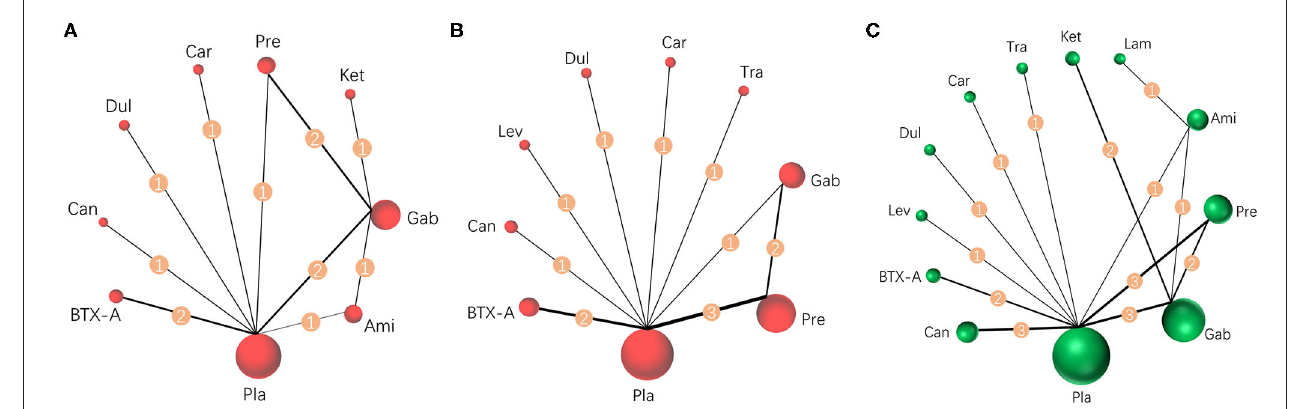
FIGURE 3 | Network meta-analysis of eligible comparisons for secondary outcomes. (A) Pain relief more than 8 weeks, n = 615. (B) Mental or sleep-related symptom relief, n = 825. (C) Serious adverse events, n = 1,232. Width of the lines is proportional to the number of trials, comparing every pair of treatments for secondary outcomes (numbers on the lines). Size of every circle is proportional to the number of randomly assigned participants (sample size). BTX-A, botulinum toxin-A; Ket, ketamine; Ami, amitriptyline; Lam, lamotrigine; Pre, pregabalin; Dul, duloxetine; Gab, gabapentin; Tra, tramadol; Lev, levetiracetam; Car, carbamazepine; Can, cannabinoids; Pla,